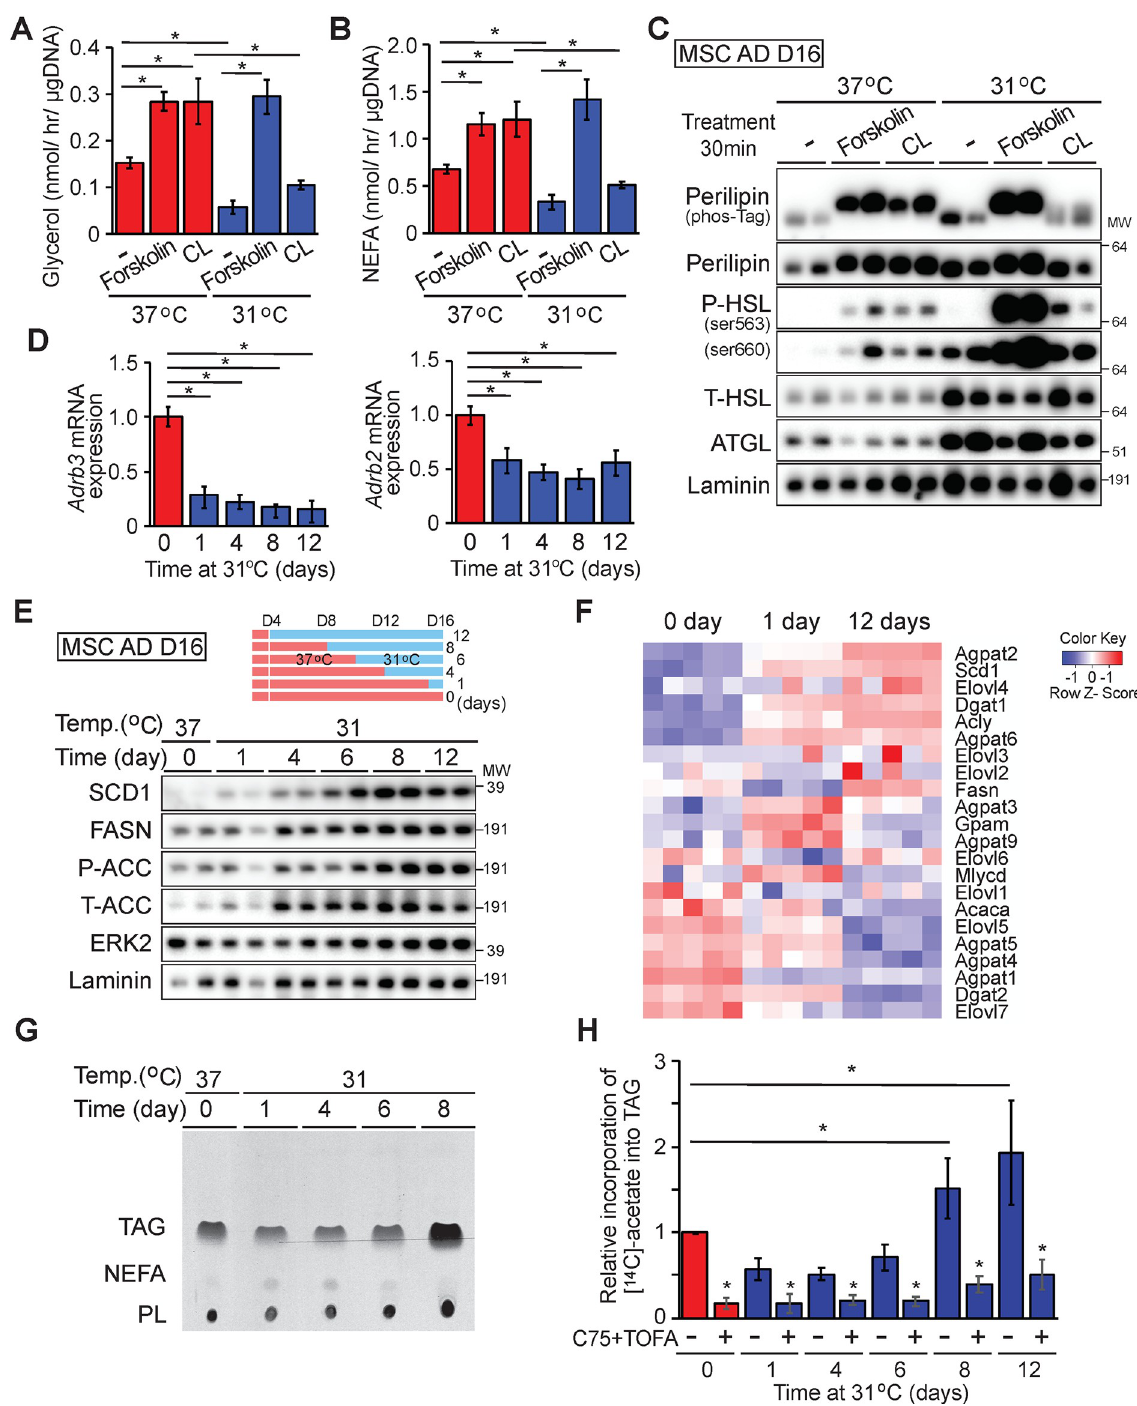
Fig 6. Adaptation to cool temperature decreases basal and stimulated lipolysis and increases de novo lipogenesis and TAG synthesis. ( A, B ) Adipocytes were treated with 10 μ M forskolin or 2 μ M CL-316,243 (CL) for 6 hours and secretion of glycerol ( A ) and NEFA ( B ) measured ( n = 4). ( C ) Cool adaptation increases expression of lipases but decreases phosphorylation of perilipin and HSL in response to CL-316,243. Adipocytes were treated with vehicle, 10 μ M forskolin, or 2 μ M CL for 30 minutes and lysed for immunoblot analyses. ( D ). Rapid reduction of β 3- and β 2-adrenergic receptor mRNAs after exposure to 31˚C ( n = 6 per time point). Gene expression was normalized to geometric mean of Hprt , Tbp , and Ppia and is expressed relative to 37˚C control ( n = 4). ( E ) Expression of de novo lipogenesis-related proteins in adipocytes cultured at 31˚C. ( F ) Relative expression of de novo lipogenesis-related mRNAs after 0, 1, or 12 days of 31˚C. Genes were manually